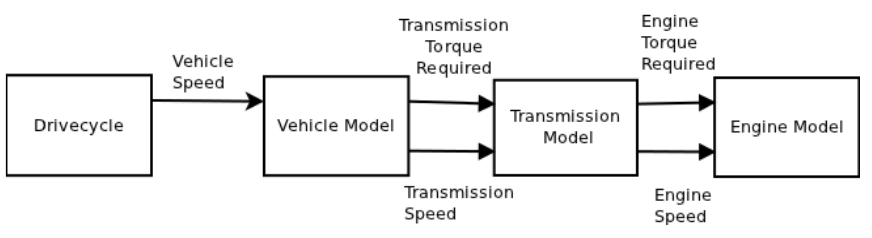
Figure 3. Backward-facing vehicle model with conventional